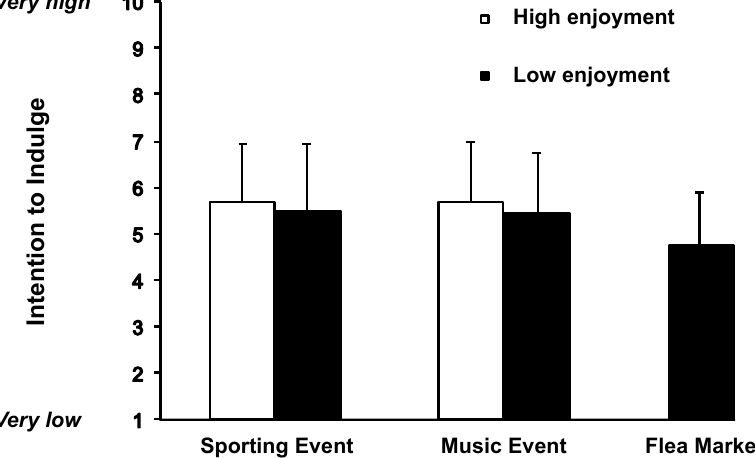
Figure 1. Intention to indulge in unhealthy foods versus healthy foods depending on the five experimental conditions: visit to a sporting event (low and high enjoyment), visit to a music event (low and high enjoyment), and visit to a flea market (low enjoyment only).